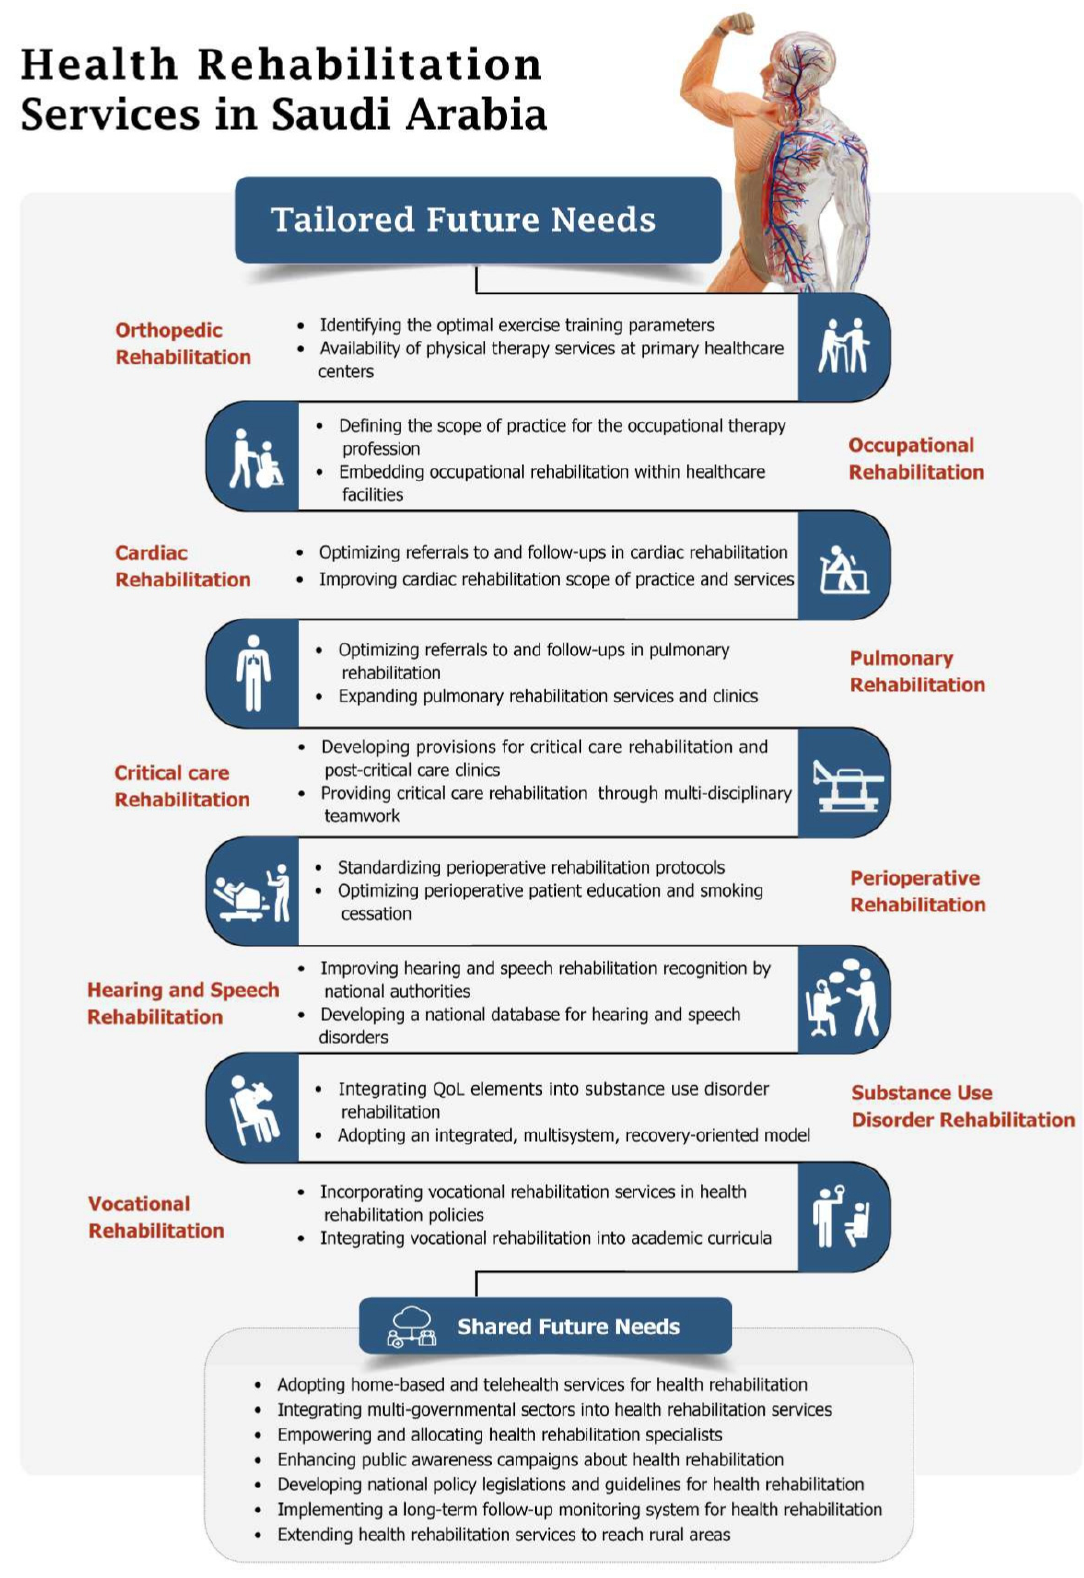
Figure 1. Tailored and shared future needs of health rehabilitation services in Saudi